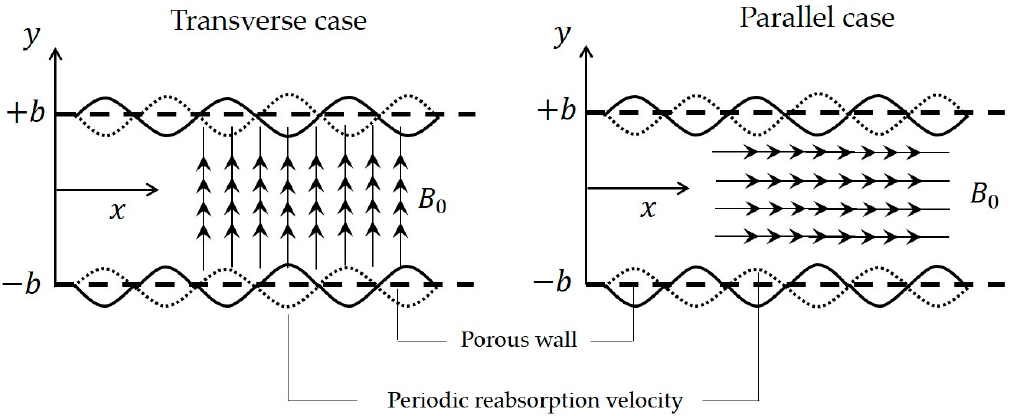
Figure 1. A sketch of the problem depicting the periodically reabsorbing porous plates and the uniform magnetic field in the y-direction (transverse case) or x-direction (parallel case).